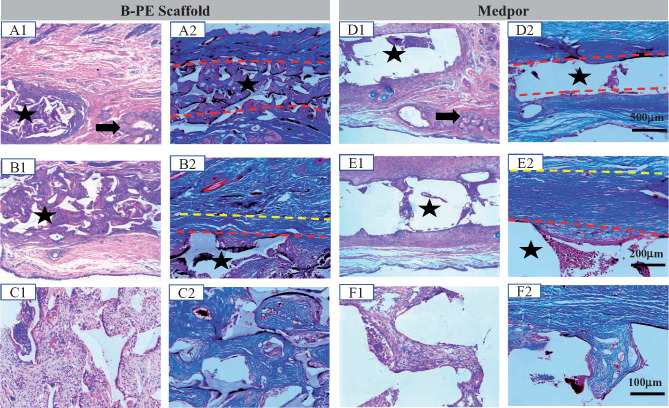
H&E staining (A1–F1) and Masson staining sections of (A2−F2) of (A–C) B-PE and (D–F) Medpor implants in rabbit eyelid defects at the fourth week. Asterisks represent scaffolds. Black arrows point to the normal meibomian glands. Red lines represent interface of tissues and materials. Tissues between the red and yellow lines are defined as the fibrous capsules